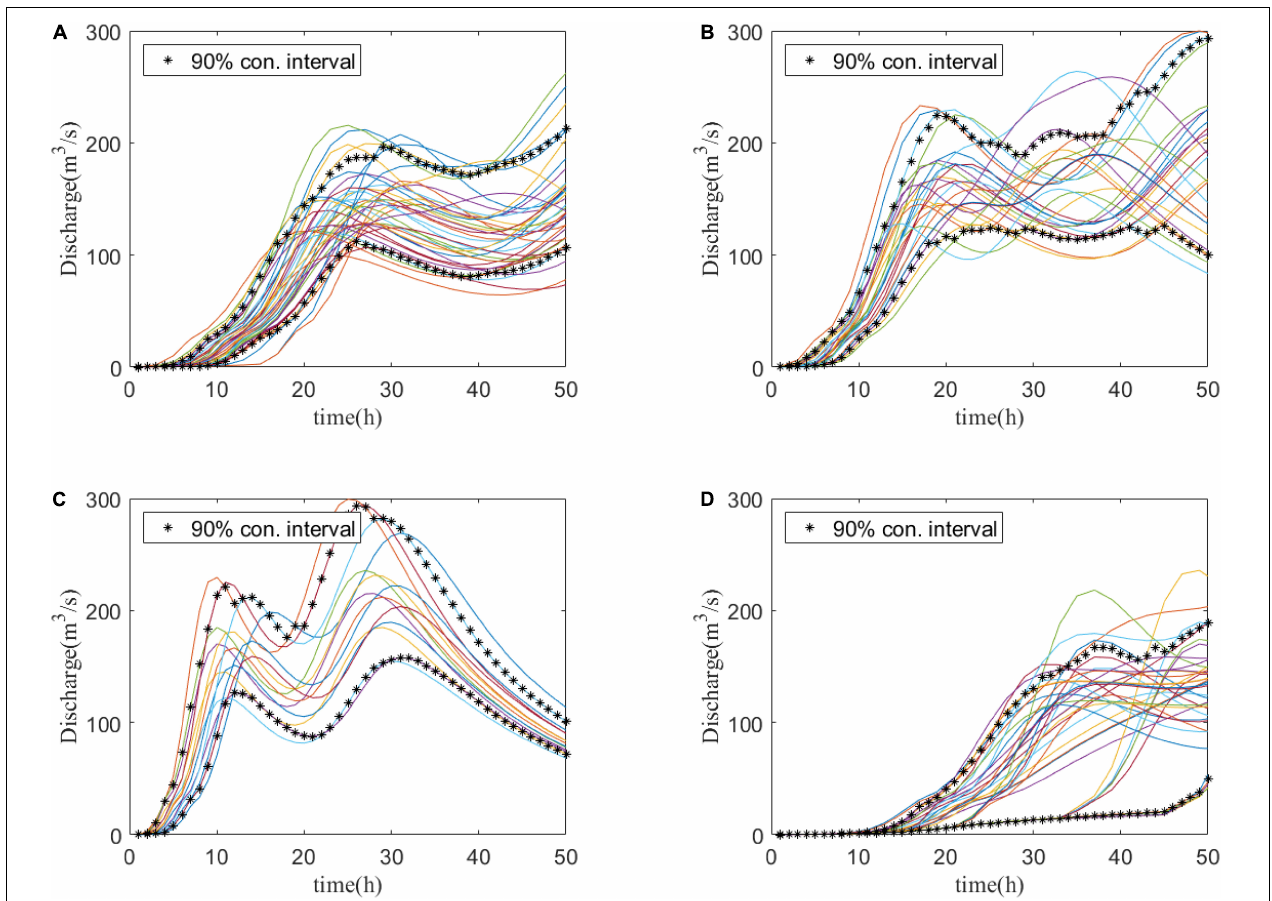
FIGURE 8 | Clustering of all the discharge curves in training dataset of Stream Red Main (biggest inflow) into four clusters by PCA-FCM. Each curve represents a single event. (A–D) The curves are clustered into the above four clusters. Asterisks represent the 90% confidence intervals of the four clusters (A–D) .